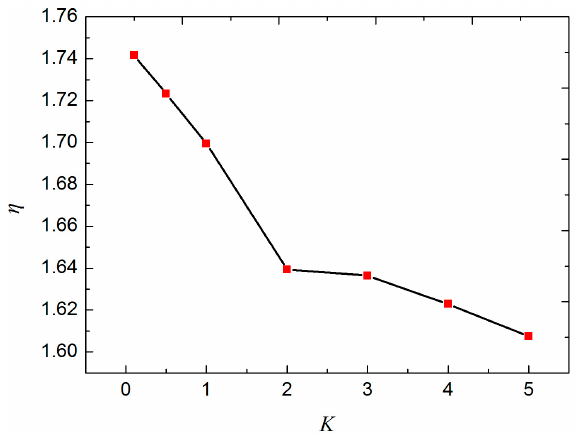
Figure 8. The FLAC results of η crest (where ξ = 0.4).